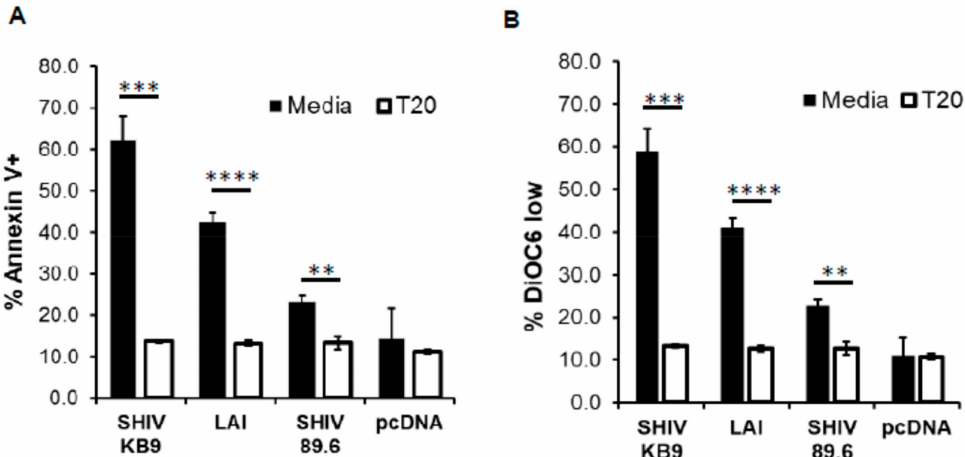
Figure 2. HIV gp41 inhibitor T20 inhibits SHIV KB9 mediated bystander apoptosis. HeLa cells transfected with di ff erent Env constructs or control vector were cocultured with SupT cells in